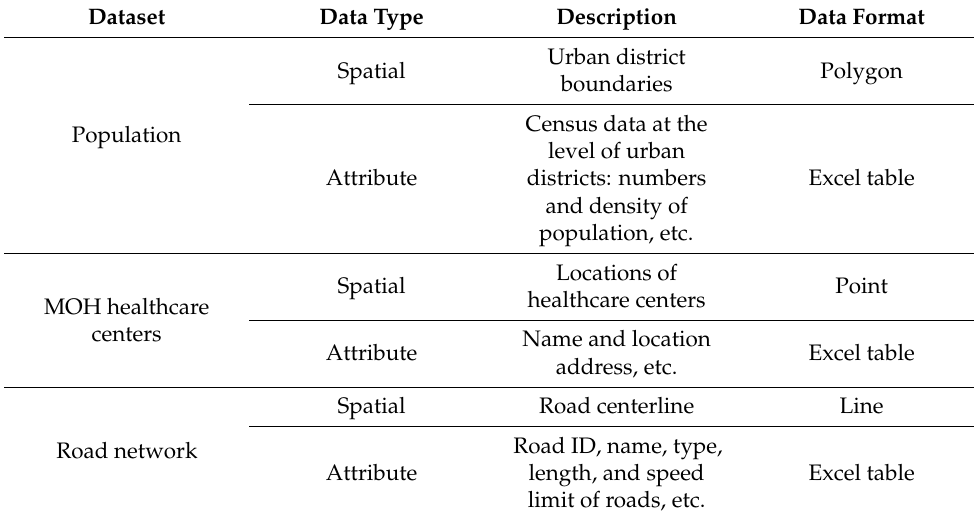
Table 1. A summary of data